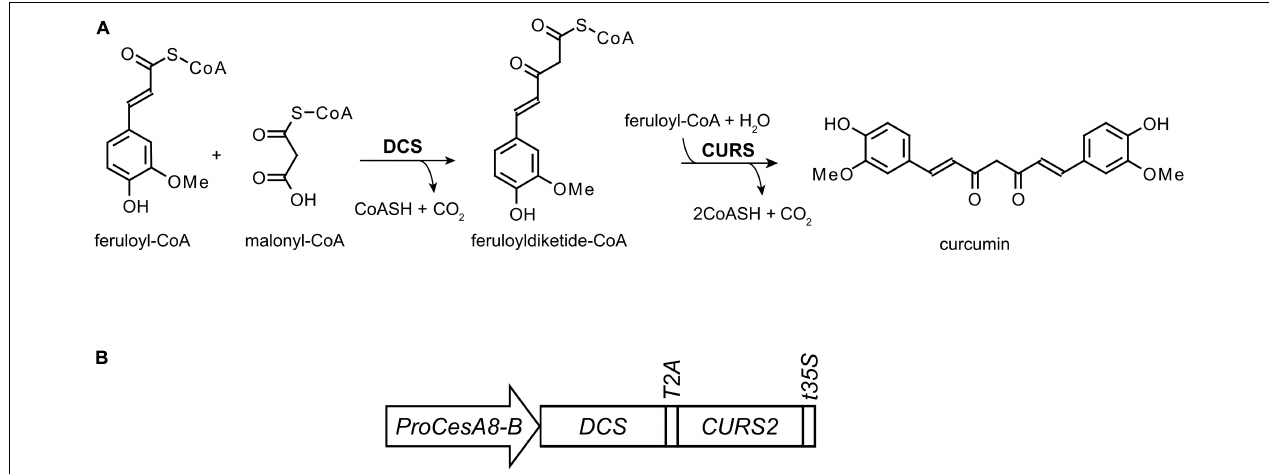
FIGURE 1 | Curcumin biosynthesis. (A) In turmeric, DIKETIDE-CoA SYNTHASE (DCS) and CURCUMIN SYNTHASE (CURS) convert two molecules of feruloyl-CoA and one molecule of malonyl-CoA into curcumin, which is characterized by two phenolic ring structures linked via a 7-carbon unsaturated aliphatic chain. (B) For the biosynthesis of curcumin in poplar, the coding sequences of DCS and CURS2 genes were linked together by the T2A sequence, and put under control of the CELLULOSE SYNTHASE 8-B promoter ( ProCesA8-B ) and terminated with a 35S terminator sequence ( t35S